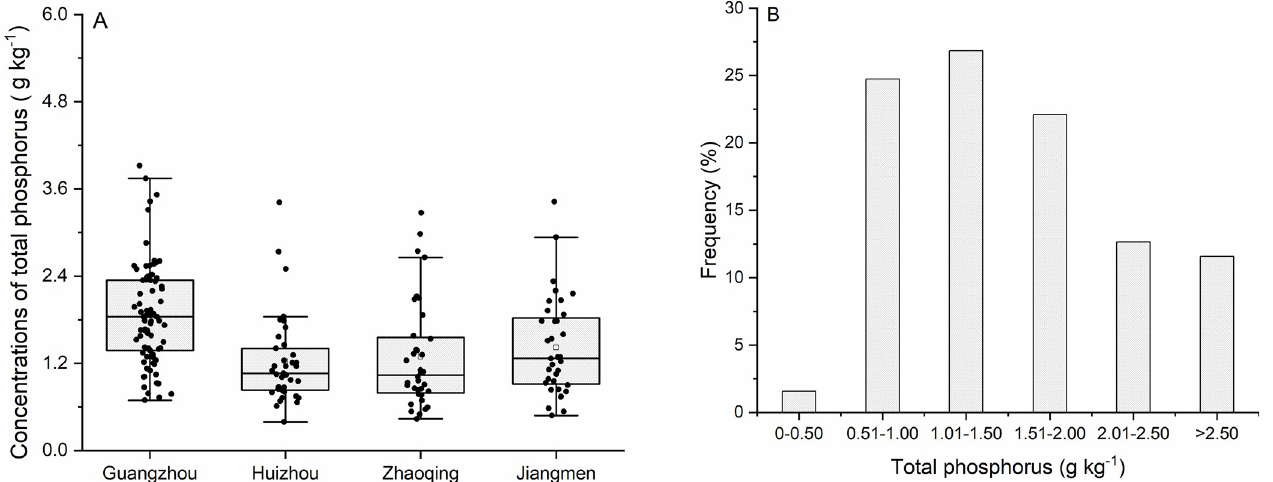
Fig 2. Concentrations (A) and frequency distribution (B) of total phosphorus in studied soils. https://doi.org/10.1371/journal.pone.0264189.g002 average value of 124.49 mg P kg -1 . The ratio of soil AP to TP is defined as the phosphorus acti- vation coefficient (PAC) [40], and in the present study, the mean PAC value of 8.33%, 8.69%, 8.27%, and 8.33% was obtained, with corresponding coefficients of variation (CV) of 44.8%, 32.5%, 40.4%, and 37.1%, for soils collected in Guangzhou, Huizhou, Zhaoqing, and Jiang- meng, respectively (Table 2). At the regional scale (the entire research area), PAC values ran- ged from 1.58 to 19.89%, with an average of 8.39% (Table 2). Based on data provided by the Second National Soil Census in China in 1980, soil TP and AP levels in the farmlands of Guangdong Province were 0.087% ± 0.010% (equivalent to 0.87 g P kg -1 ) and 14.6 ± 3.4 mg P kg -1 [31], respectively. Our findings in the present study revealed that there have been significant increases in both soil TP and AP concentrations in the period from 1980 to 2019, which were estimated to have increased by 78% and 753%, respectively,